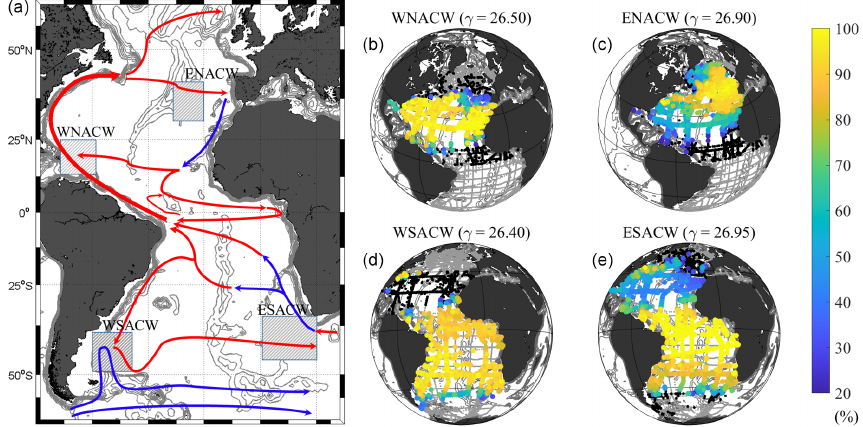
Figure 8. Currents (a) and water masses (b, c, d, e) in the upper layer. (a) The warm (red) and cold (blue) currents (arrows) and the formation areas (rectangular shadows) of water masses in the upper layer. (b, c, d, e) The coloured dots show fractions from 20% to 100% of water masses in each station around its core neutral densities (kgm − 3 ). Stations with fractions less than 20% are marked by black dots, while grey dots show all the GLODAPv2